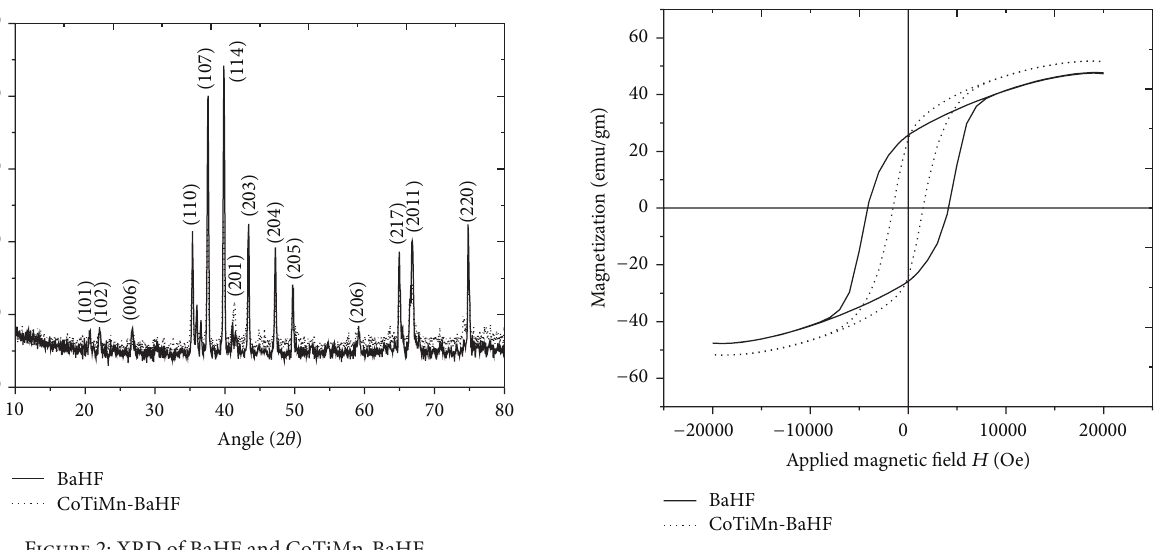
Figure 3: Hysteresis plot of BaHF and